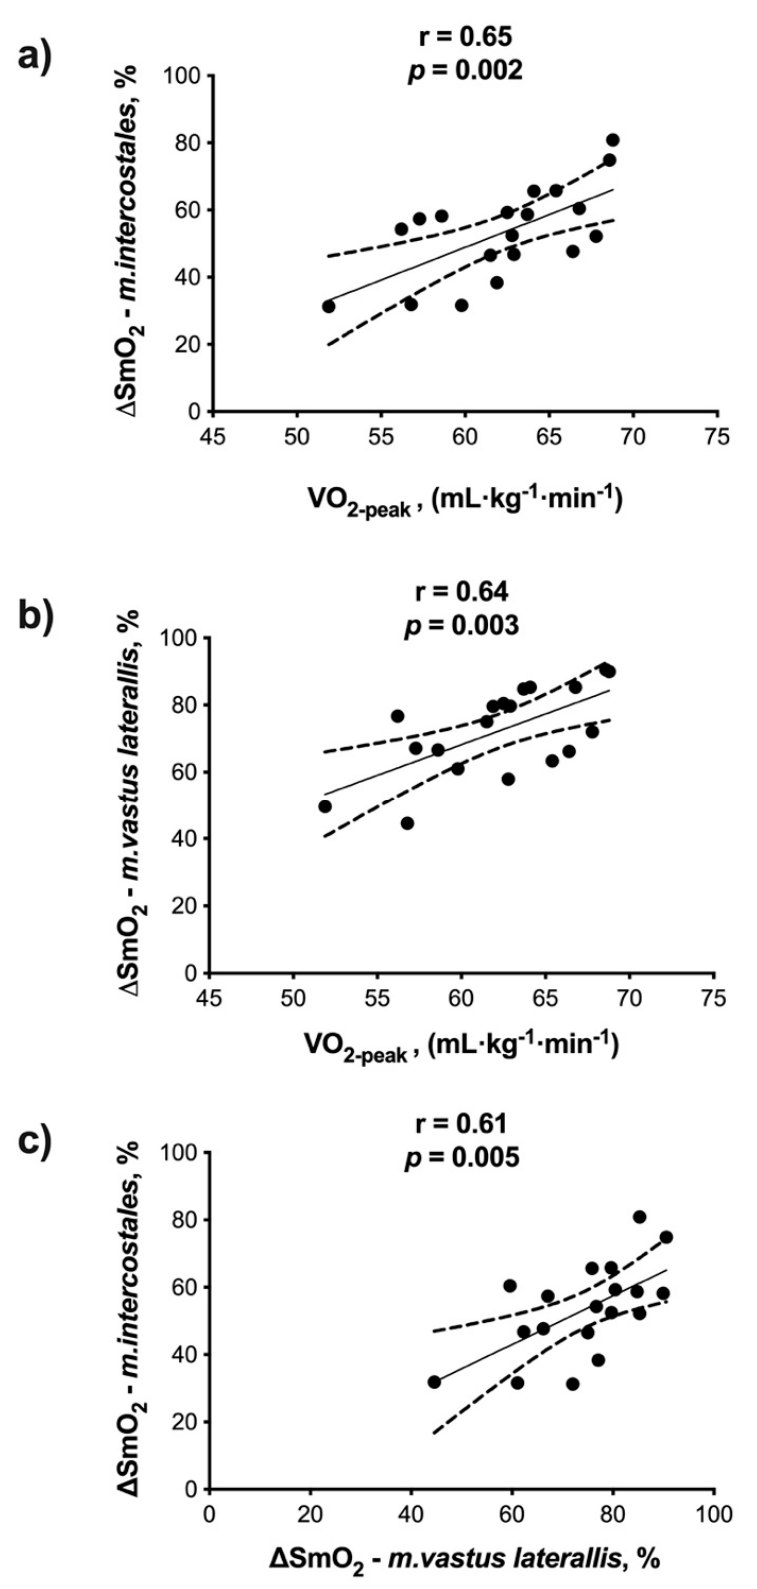
Figure 3. Association between VO 2 (oxygen consumption) and: ( a ) ∆ SmO 2 - m.intercostales and ( b ) ∆ SmO 2 -m.vastus laterallis . ( c ) Association between ∆ SmO 2 - m.intercostales and ∆ SmO 2 -m.vastus laterallis .